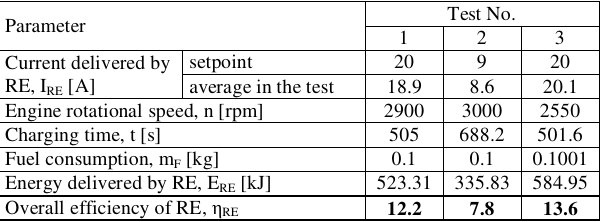
of the range extender